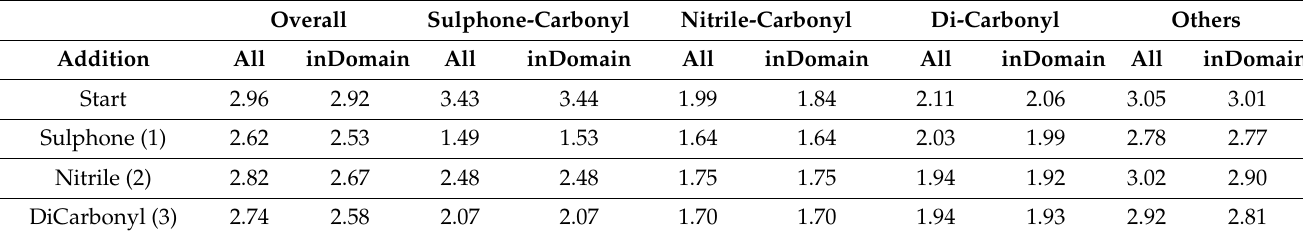
Table 2. RMSE values of the carbon acids in the test set trained with additional incorporated compounds. Overall Sulphone-Carbonyl Nitrile-Carbonyl Di-Carbonyl Others Addition